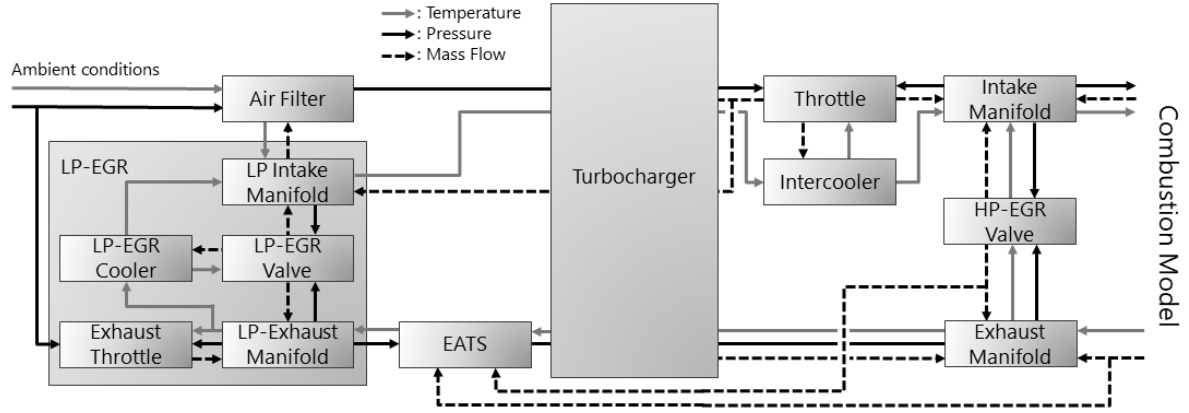
Figure 2. Schematics of the engine air path sub-components.